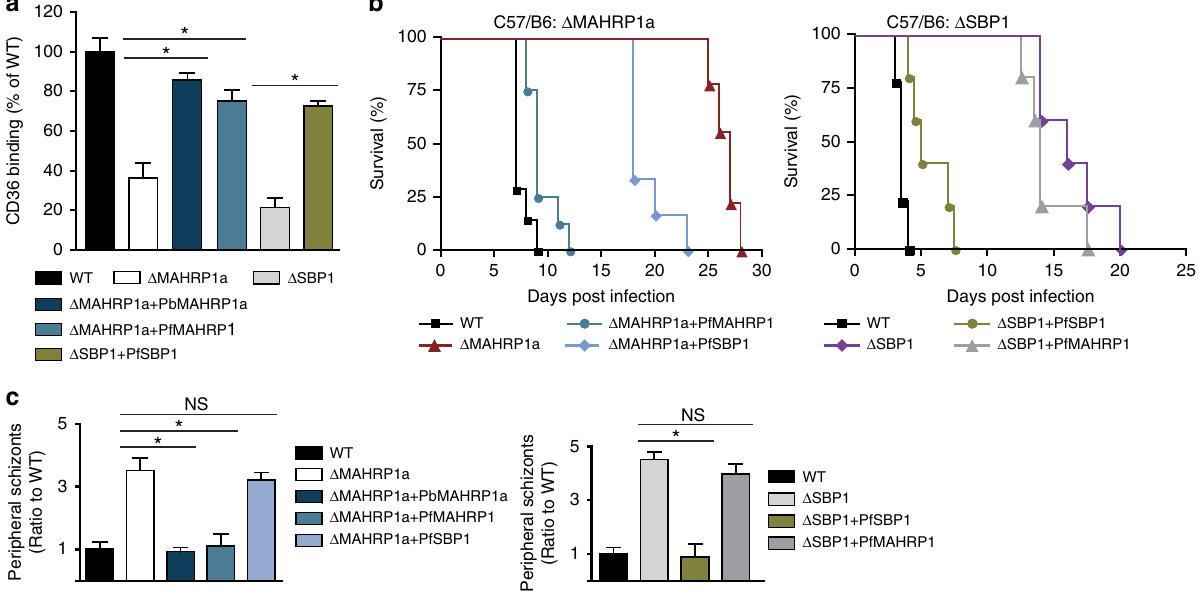
Figure 4 | Heterologous complementation of the mutants Pb D mahrp1a and Pb D sbp1 with Pf mahrp1 and Pf sbp1 rescues binding of iRBCs to CD36 and virulence phenotype. ( a ) The matched complemented mutants showed significantly increased binding to purified CD36 compared with the gene-deletion mutants (binding indicated as % of wt; * P o 0.0001, one-way ANOVA, Tukeys post hoc test.; n ¼ 3). ( b ) Survival of C57B/6 mice infected with matched complemented mutants was significantly increased in comparison with the mutants and the mismatched complemented mutants ( n ¼ 9 mice per group, P o 0.001, logrank test from Kaplan–Meier survival curve). ( c ) Significant decrease in number of schizonts in the peripheral blood circulation in matched complemented mutants compared with the gene-deletion mutants and to mismatched complemented mutants. Schizonts were quantified in Giemsa-stained smears of tail blood obtained 22h after establishing synchronised infections ( n ¼ 9 mice per group; * P o 0.0001, one-way ANOVA, Tukeys post hoc test).